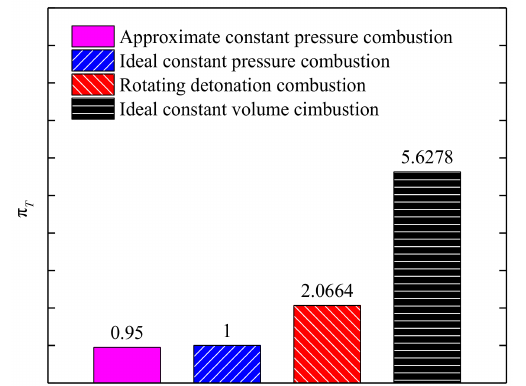
Figure 6. Pressure ratios using different combustors.